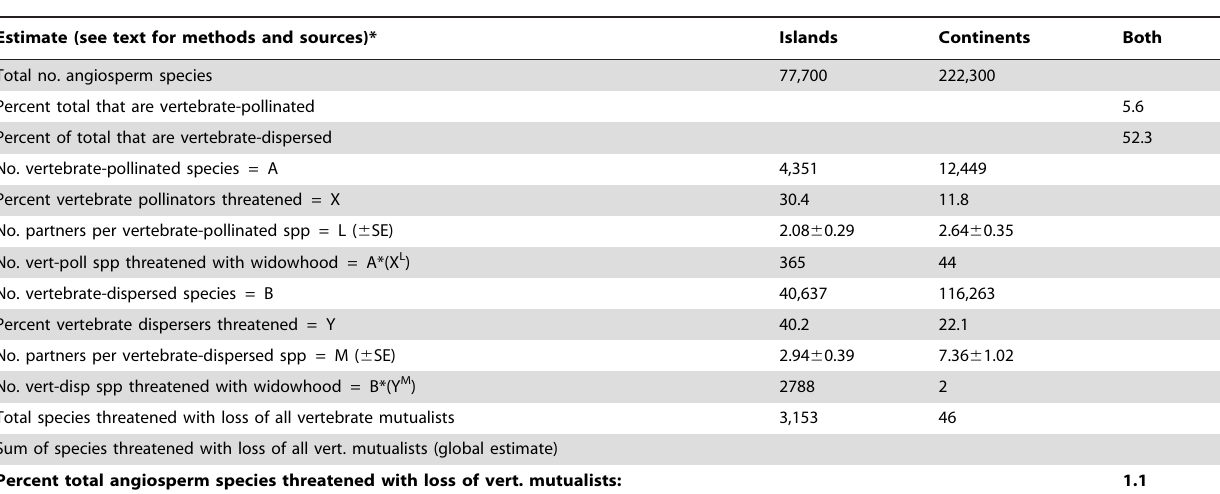
Table 1. Constituent values used to estimate the number of plants likely to be widowed if currently threatened vertebrate species become